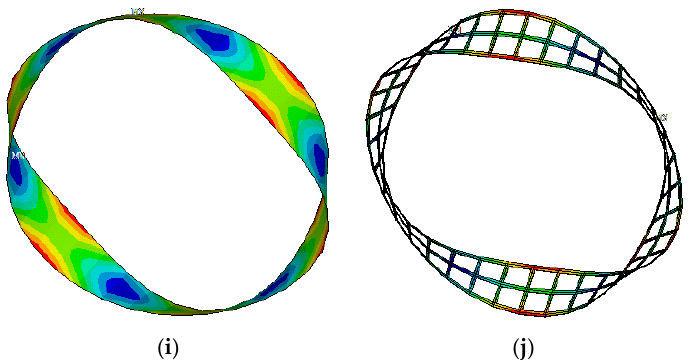
Figure 10. 1st~5th order modes calculated using the shell model and the updated beam model. ( a ) 1st mode for shell model (7.35 Hz); ( b ) 1st mode for updated beam model (7.3104 Hz); ( c ) 2nd mode for shell model (18.555 Hz); ( d ) 2nd mode for updated beam model (19.810 Hz); ( e ) 3rd mode for shell model (20.85 Hz); ( f ) 3rd mode for updated beam model (20.969 Hz); ( g ) 4th mode for shell model (40.17 Hz); ( h ) 4th mode for updated beam model (41.020 Hz); ( i ) 5th mode for shell model (60.255 Hz); ( j ) 5th mode for updated beam model (60.621 Hz).